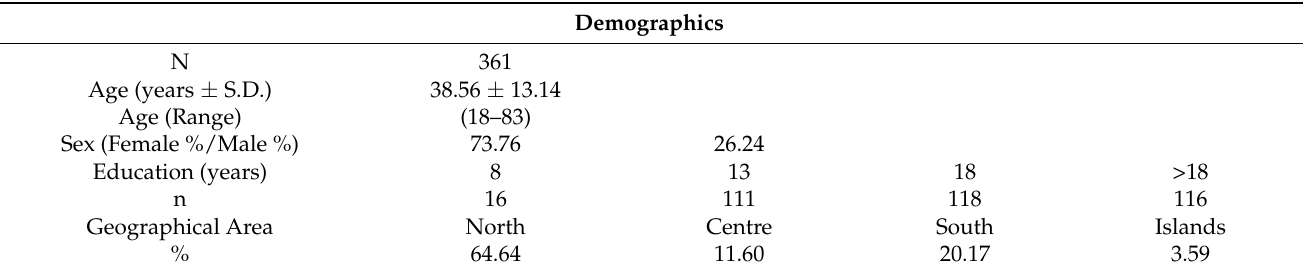
Table 2. Demographic Data of the sample.